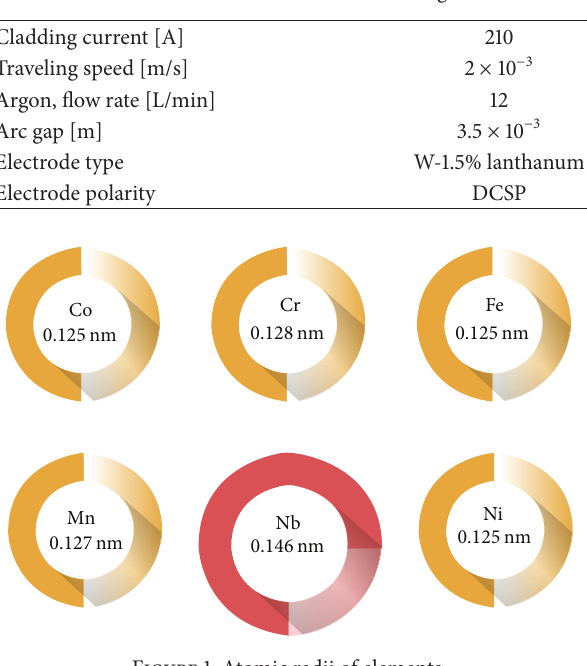
Table 2: Parameters of the cladding.